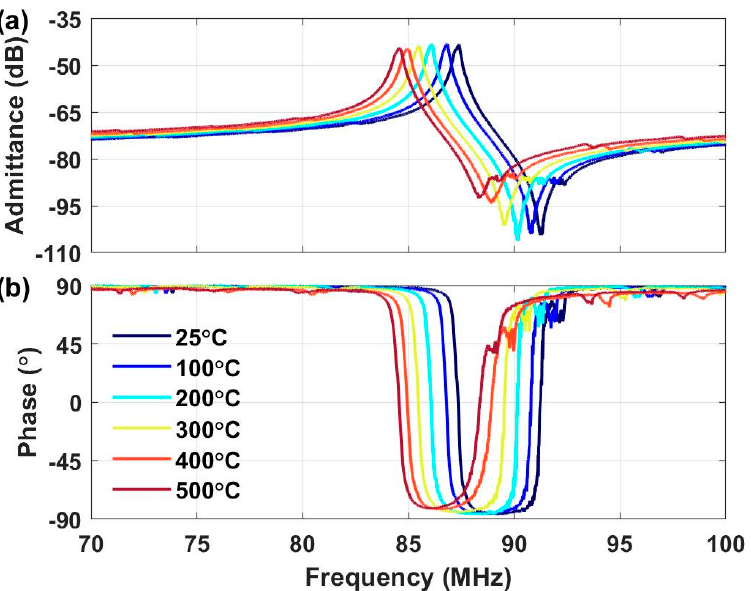
Figure 5. Measured amplitude ( a ) and phase ( b ) of the admittance of the LN MEMS LVR array from 25 °C to 500 °C.